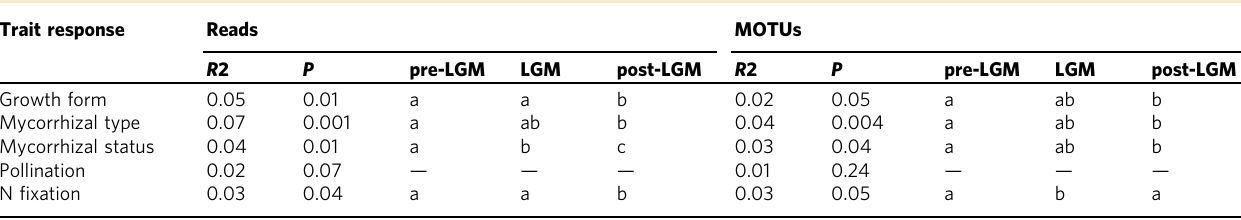
Table 2 Variation in the relative abundance of sequencing reads corresponding to different trait categories (Reads) and in the relative abundance of taxa in different trait categories (MOTUs) in relation to climatic period (pre-LGM, LGM, post-LGM) Trait response